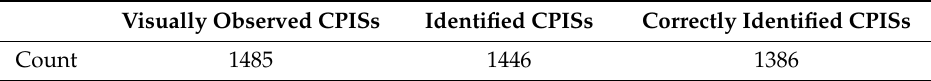
Table 1. Quantity analysis results.